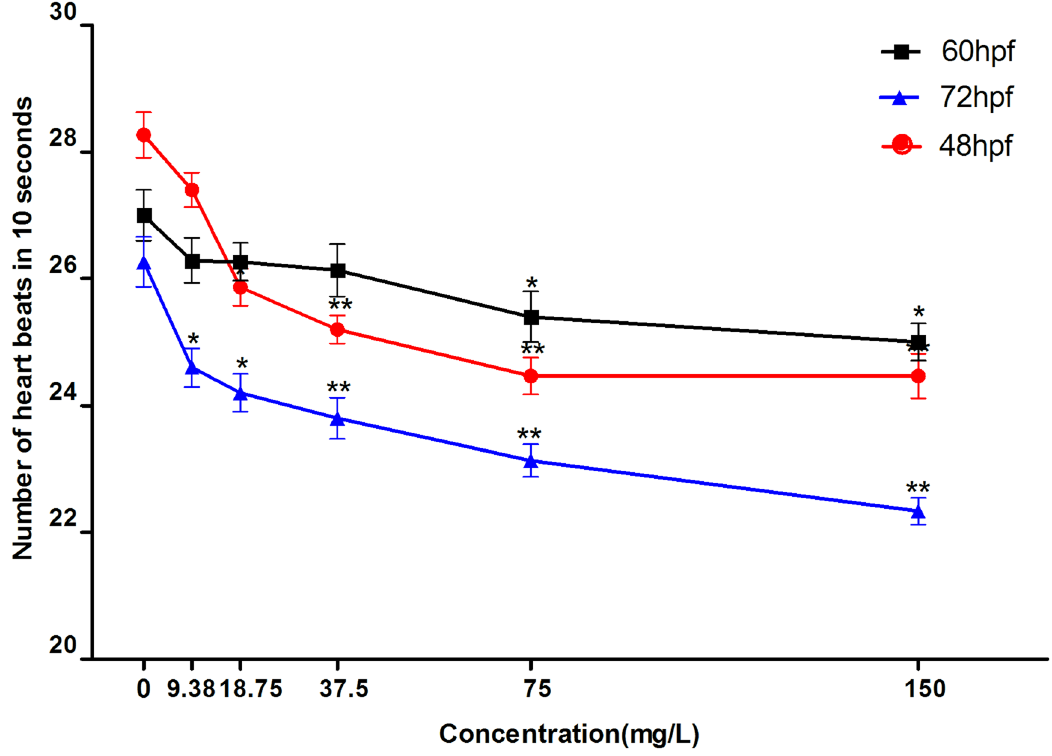
Figure 6. The heart rate of zebrafish under different DKA concentrations.